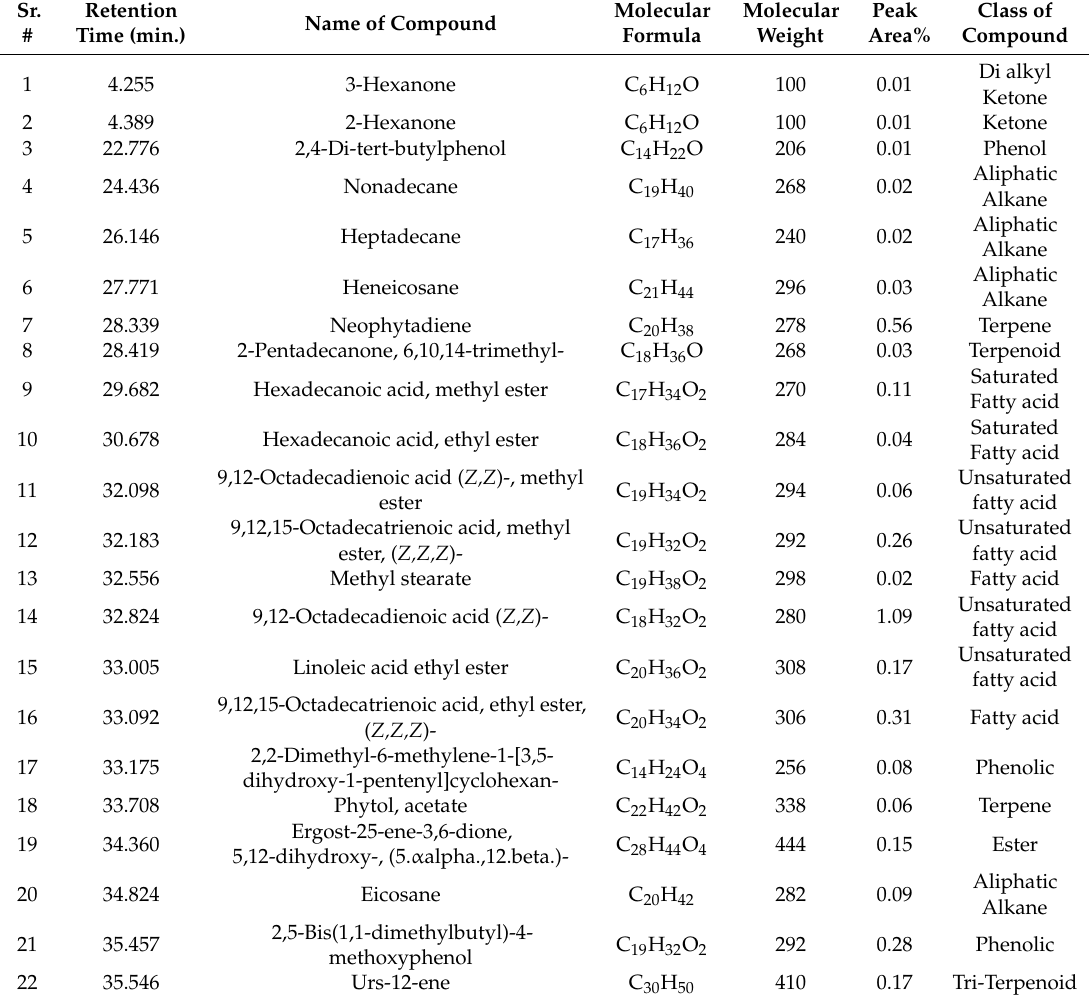
Table 1. Compounds Identified in Gas Chromatography Mass Spectrometry